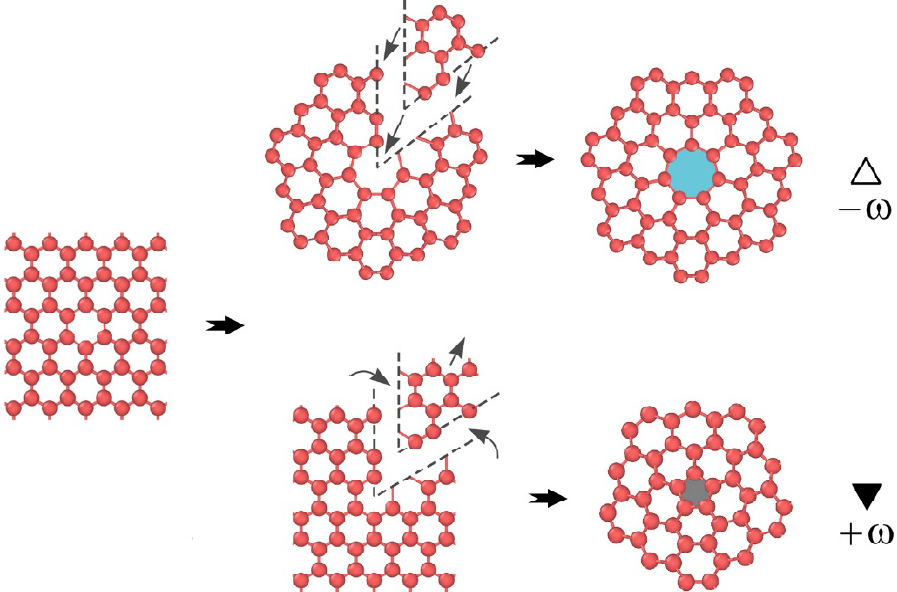
Fig. 2. Geometrical scheme of the disclination formation in graphene. The magnitude of disclination power is  = 